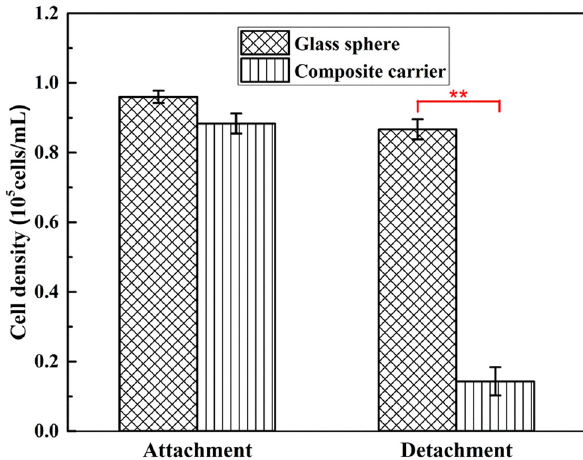
Figure 6: Attachment and detachment of BMMSCs on the glass spheres and sprayed composite carriers ( ** p < 0.05 )